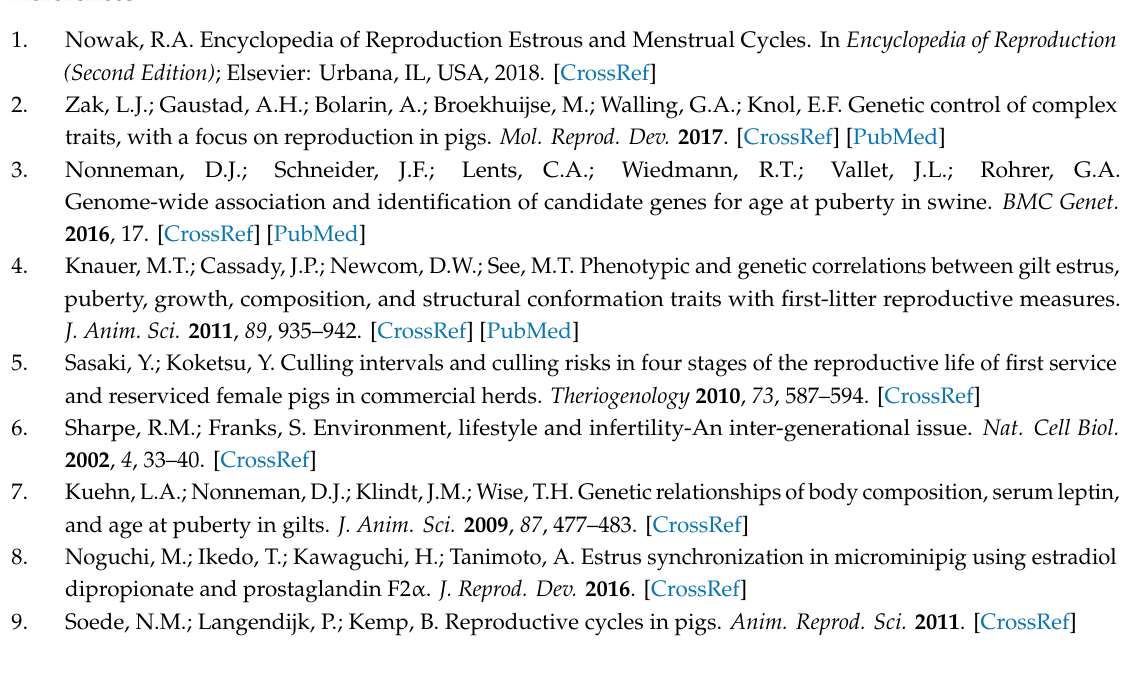
Table S1: Primer information of SNP identification for porcine HSD17B14 gene, Table S2: Primer information of plasmid construction and RT-qPCR for porcine HSD17B14 gene, Table S3: Change of transcription factor-binding sites before and after the SNPs rs329427898 and rs319864533 mutation in the promoter region of the porcine HSD17B14 gene, Table S4: The prediction of CpG island in the promoter of porcine HSD17B14 gene by Meth-Primer 2.0, Table S5: Allelic distribution of SNPs of porcine HSD17B14 gene in the Large White and Mi pigs, Table S6: The data of estrus expression in Large White and Mi